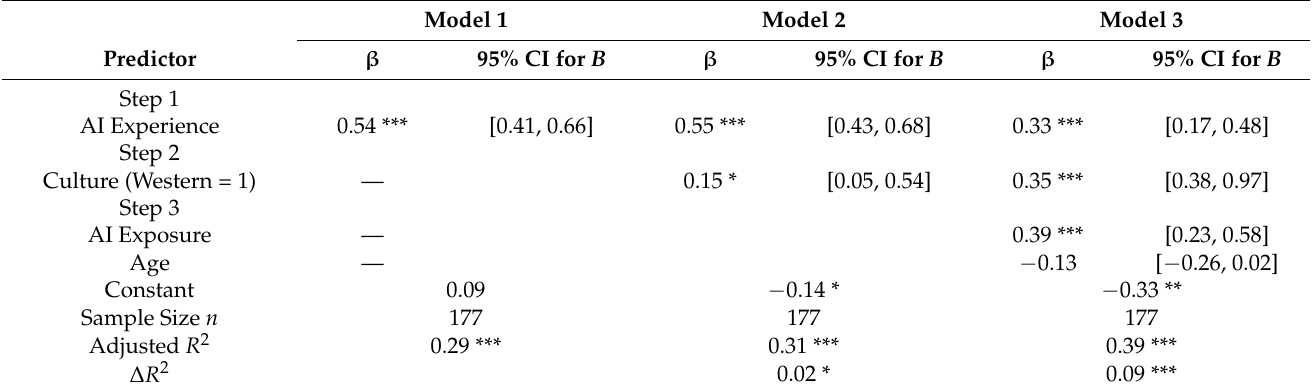
Table 8. Stepwise regression analysis of human identity, Study